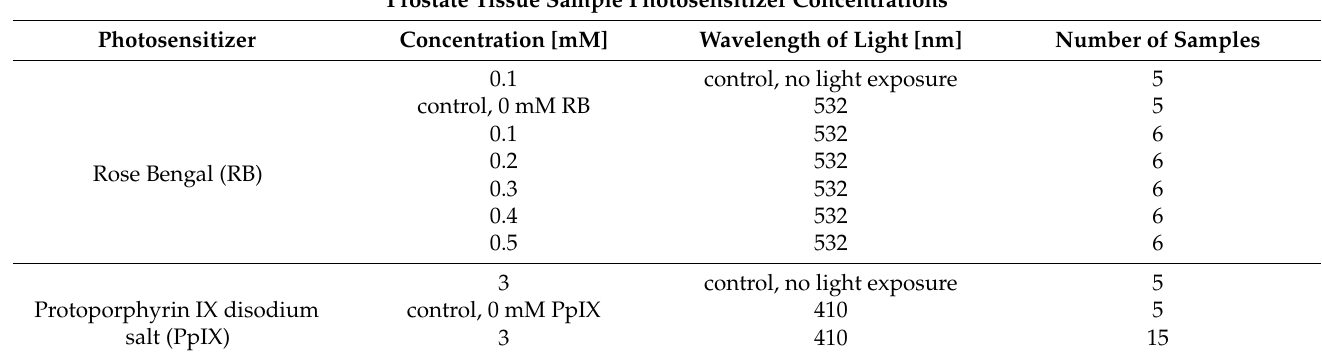
Table 1. Concentrations of photosensitizers used for PDT experiments, number of samples, and irradiation